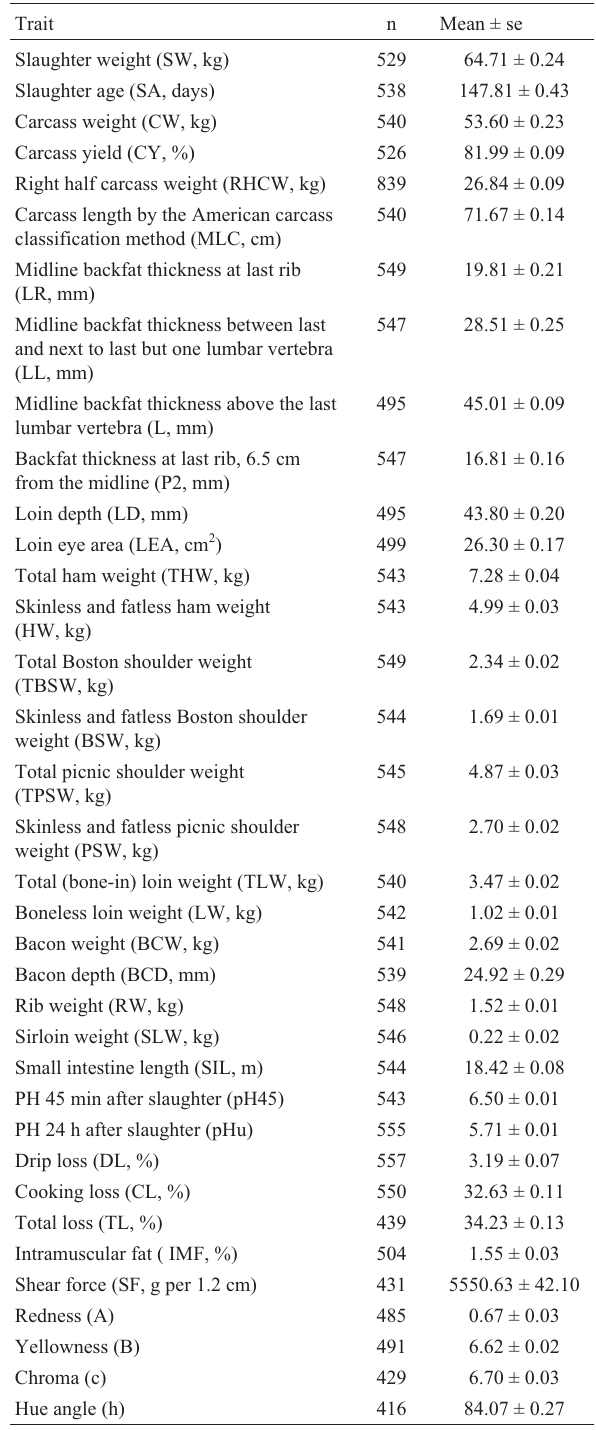
Table 2 - Number of F2 offspring analyzed (n), mean and standard error (SE) of carcass, carcass cut and meat quality